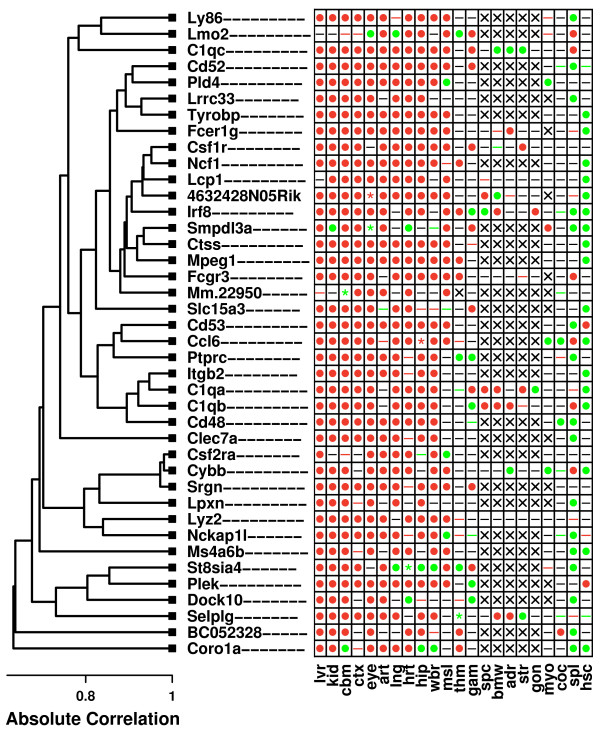
Gene expression module regulated by aging. The figure shows a 40-gene co-expression module that is regulated by aging across multiple tissue types. Symbols shown within the grid reflect results of differential expression analyses for individual genes and tissues, given a comparison-wise type I error rate of 0.05 (i.e., no p-value adjustment for multiple testing of hypotheses). These symbols have the same interpretation as those shown in Figure 2. The columns of the grid, corresponding to individual tissue types, have been ordered from those for which module genes are most strongly up regulated by age, to those for which module genes are most strongly down regulated by age. The dendrogram (left) reflects the co-expression patterns among the 40 genes belonging to this module, which are based upon the expression of genes across a set of 3,700 Affymetrix 430 2.0 oligonucleotide arrays (see Methods). The dendrogram was generated by average linkage hierarchical cluster analysis, with distance between genes based upon the absolute value of Pearson's correlation coefficient (i.e., distance = 1 - |r|). Other age-regulated co-expression modules were identified in the analysis, and further detail on the most of these is provided in Additional File 11.